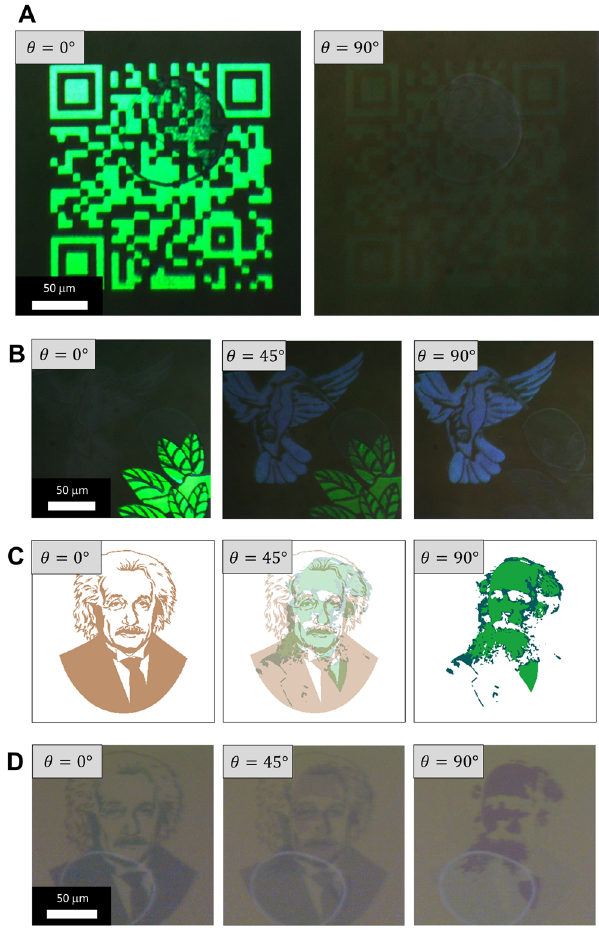
Figure 5: Cryptographic applications of the polarization-sensitive TNMs. (A) A green QR code image is turned-on and -off when θ changes from 0 ° to 90 ° . (B) Images of a tree and a bird using green and blue TNMs. The blue bird image is turned-off at θ = 0 ° , while the green tree is turned-on,whiletheoppositeistrueat θ =90 ° .Anintermediateimage is displayed at θ = 45 ° . Two polarization-selective overlapped images are demonstrated with the portraits of Einstein and Boltzmann . (C) Intended images of the TNMs. (D) Captured images using an optical microscope from the fabricated TNM for θ = 0 ° , 45 ° , and 90 °